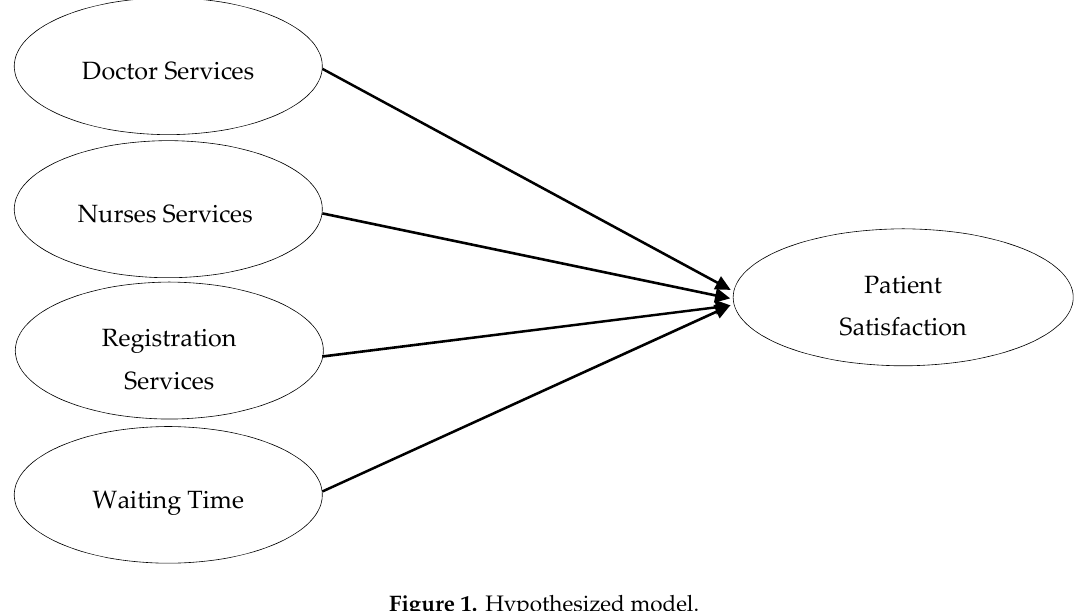
Figure 1. Hypothesized model.